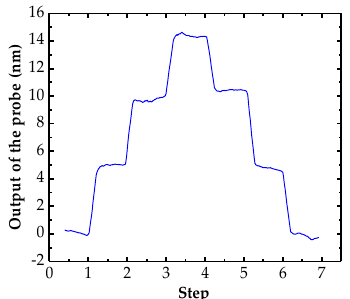
Figure 13. Results of the resolution test for the probe.